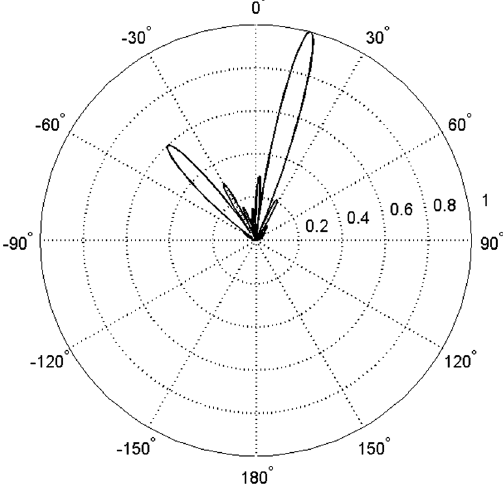
FIG. 9. Far-field plot of the beam splitter with 25 unit cells.